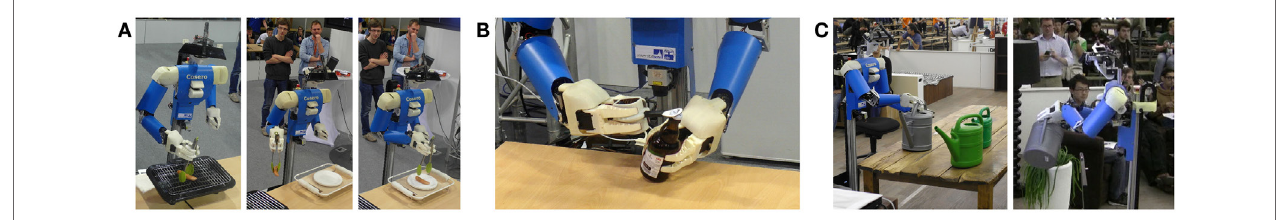
FIgURe 11 | Tool use . (A) Grasping sausages with a pair of tongs. Cosero perceives position and orientation of the sausages in RGB-D images (Stückler and Behnke, 2014a). (B) Bottle opening. (c) Plant watering skill transfer to unknown watering can (Stückler and Behnke, 2014b; cf. to Figure 8e